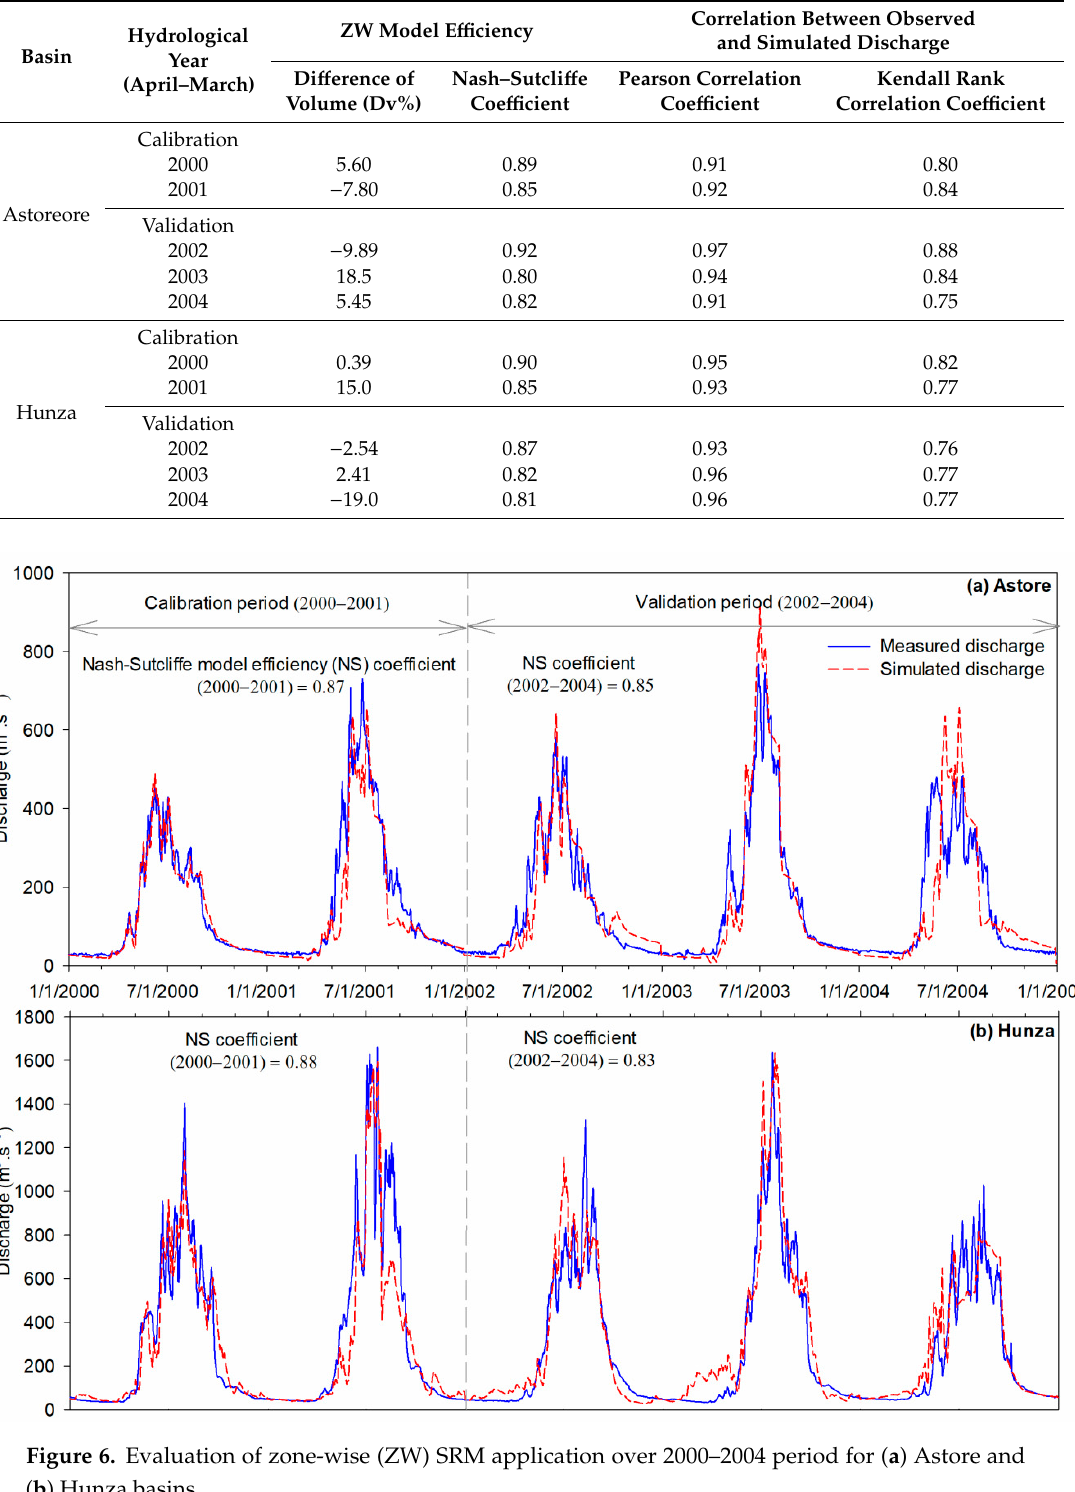
Table 7. E ffi ciency of the zone-wise SRM application to simulate Astore and Hunza river discharge.